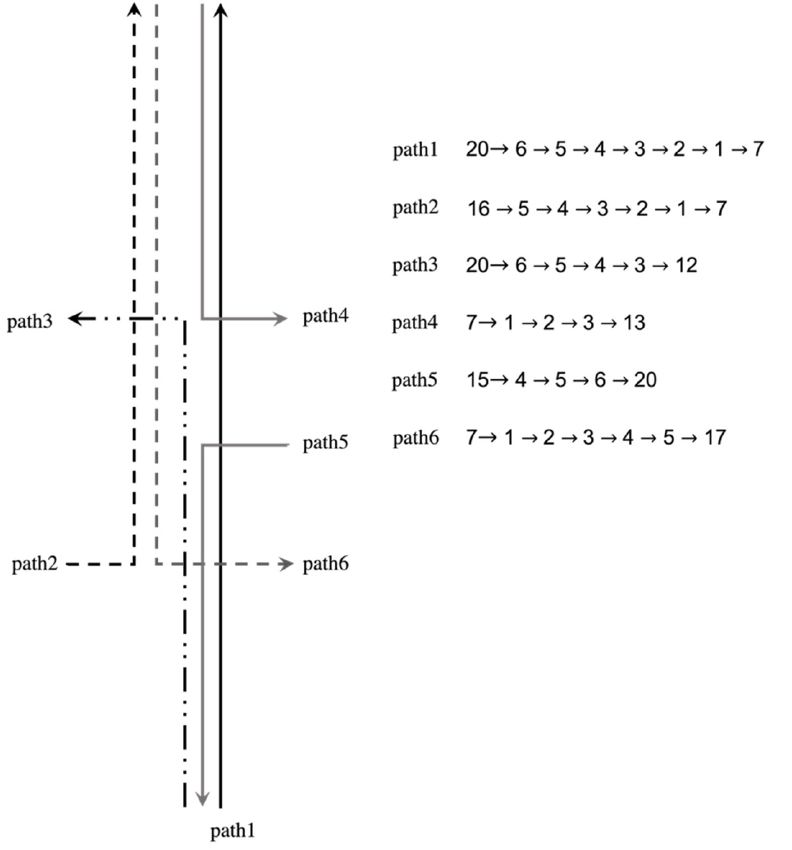
Figure 9. Critical path distribution.